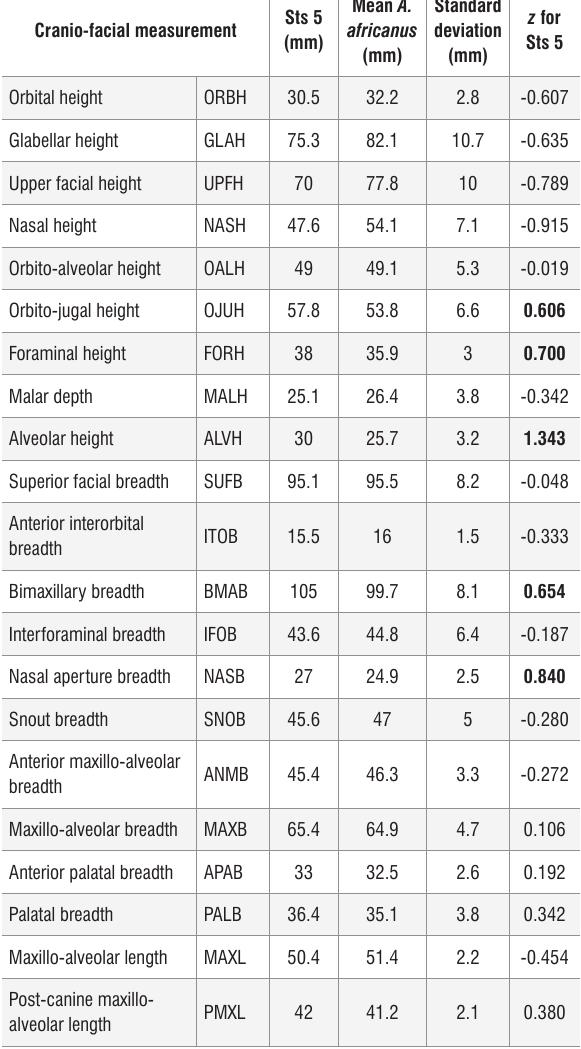
Measurements of 21 craniometric distances of Sts 5 in